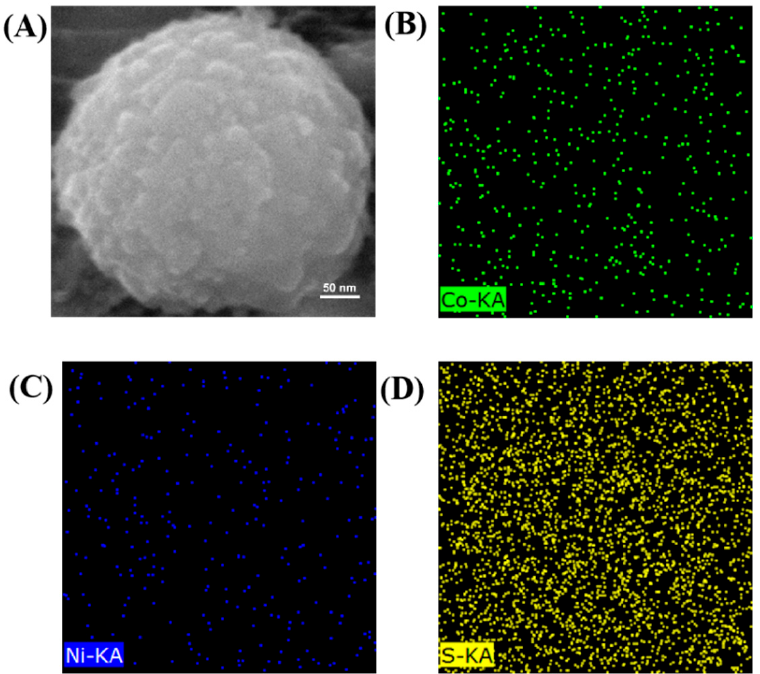
Figure A1. SEM image ( A ) and the elemental distribution maps of Co ( B ), Ni ( C ) and S ( D ) of Co 0.6 Ni 0.4 S 2 /rGO.